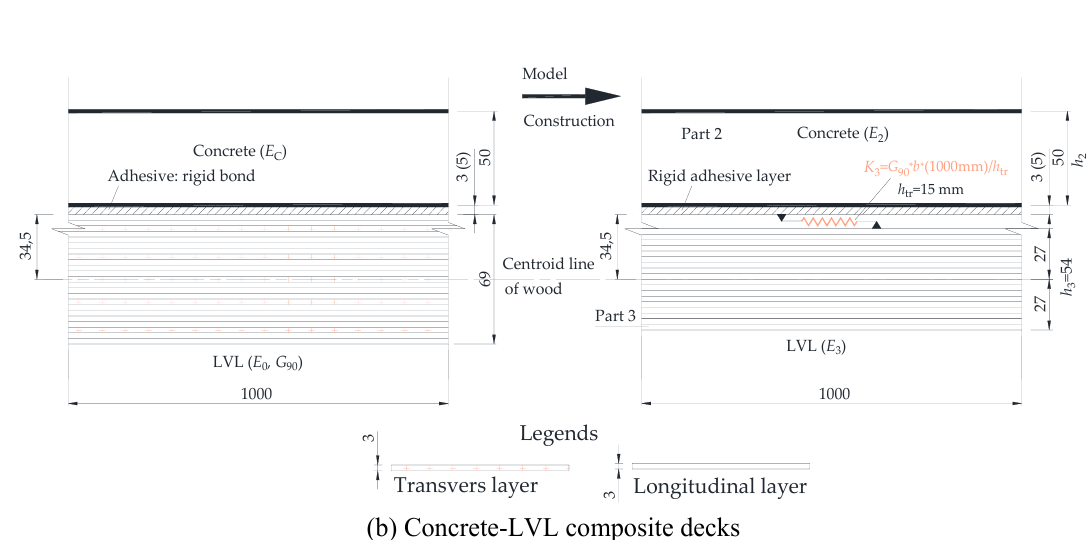
Figure 4. Analytical model of composite decks (unit: mm) - quoted from Ref.